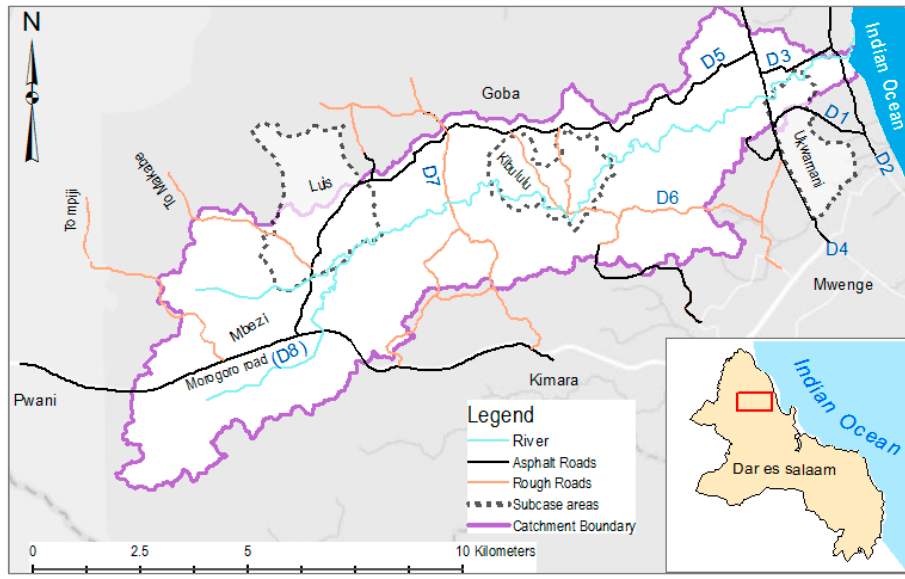
Figure 1. Delineation of Mbezi River Catchment in Dar es Salaam, Tanzania, serving as case study area. The three sub-case study areas (Luis, Kibululu and Ukwamani) are indicated, as are the roads for which drainage channels have been assessed (D1 to D8).